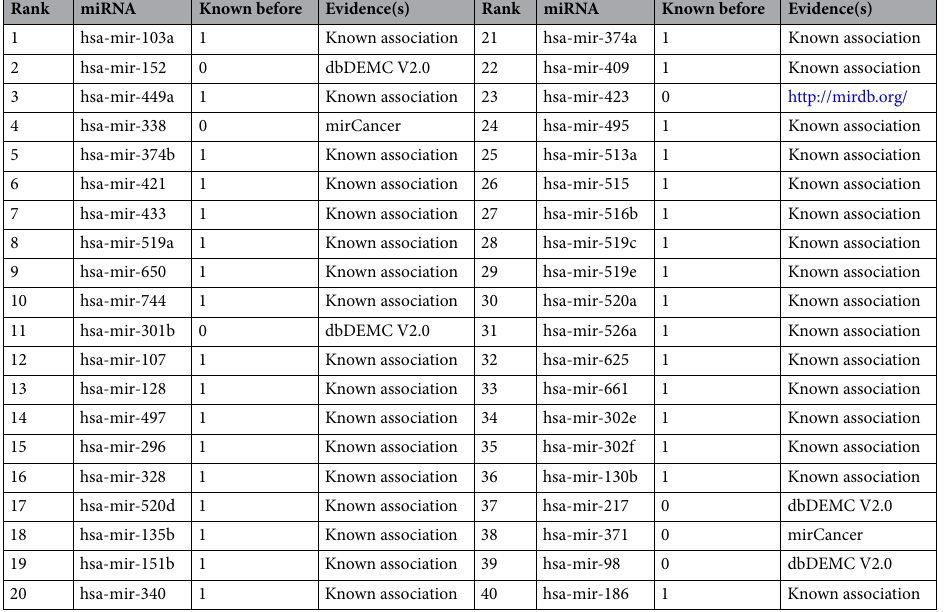
Table 5. Top 40 predicted stomach neoplasms-associated